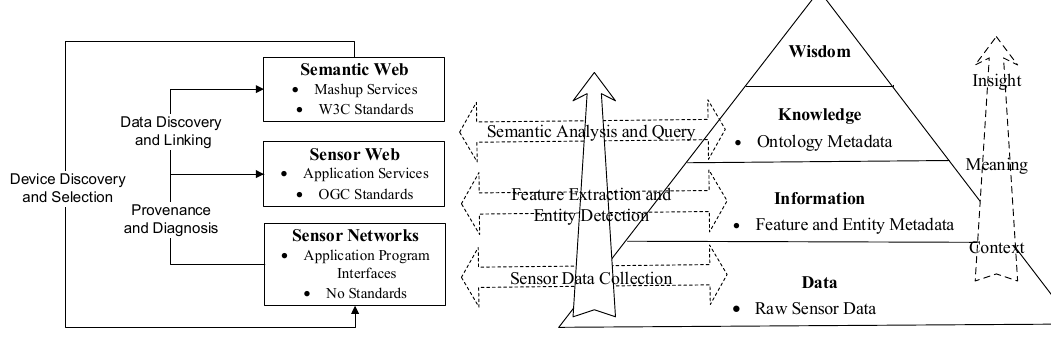
Figure 3. Sensor Data-to-Knowledge Pyramid.